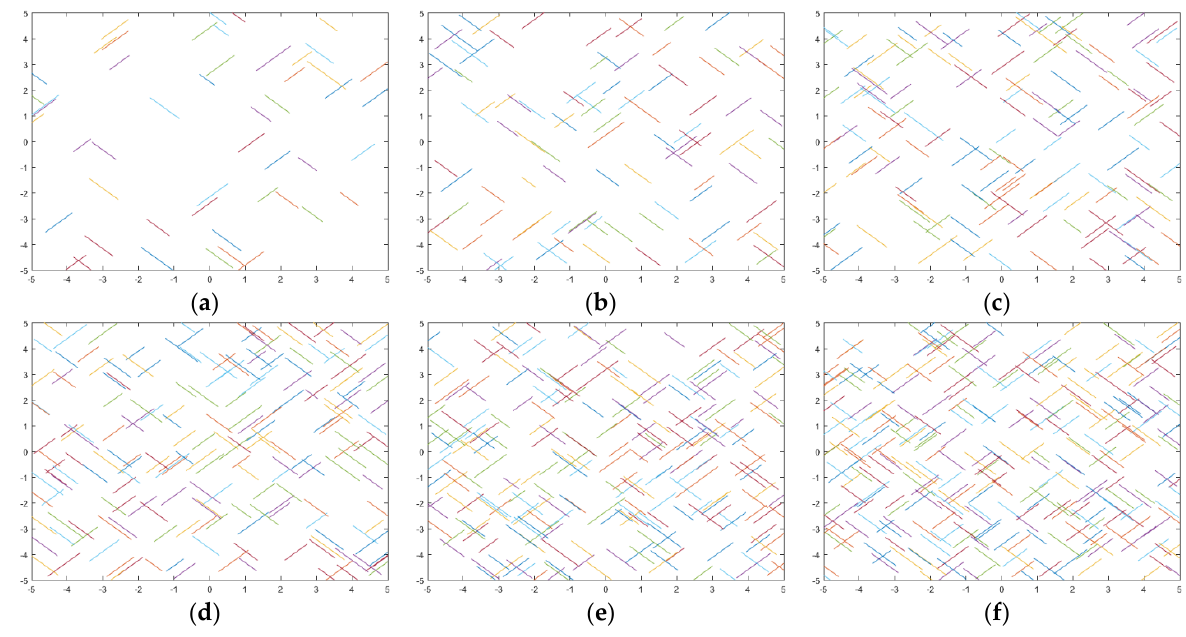
Figure 4. Natural joint distributions with various joint densities (x-axis and y-axis are the horizontal and vertical dimensions (m)). ( a ) 0.5 curve/m 2 , ( b ) 1.0 curve/m 2 , ( c ) 1.5 curve/m 2 , ( d ) 1.9 curve/m 2 , ( e ) 2.4 curve/m 2 , ( f ) 2.8 curve/m 2 .